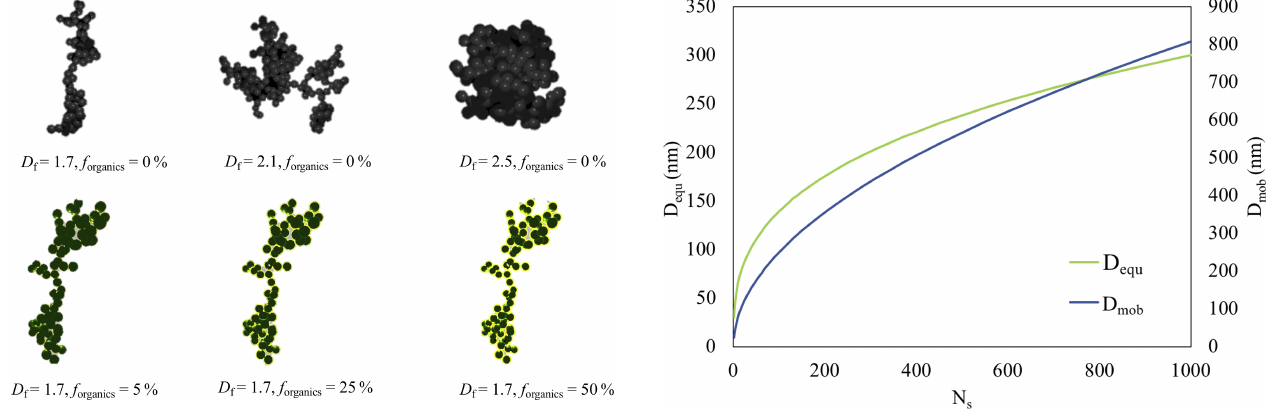
Figure 3. Relationship between mobility diameter ( D mob ), number of primary particles ( N s ), and volume equivalent diameter ( D equ ) for pure BCFAs with a o =